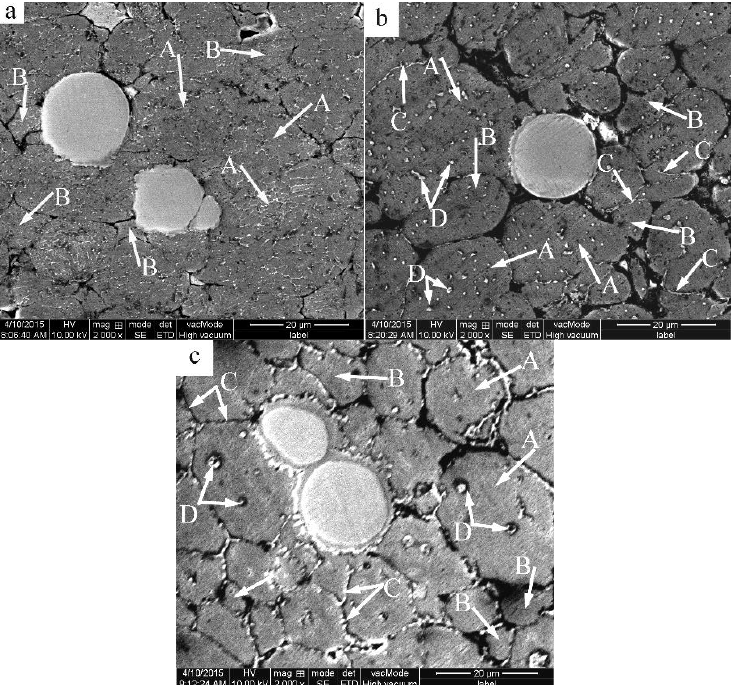
Figure 4. SEM micrographs of the mixed powder bulk alloy heated at 640 °C for different time lengths and then water-quenched. ( a ) 5 min; ( b ) 10 min; ( c ) 15 min.